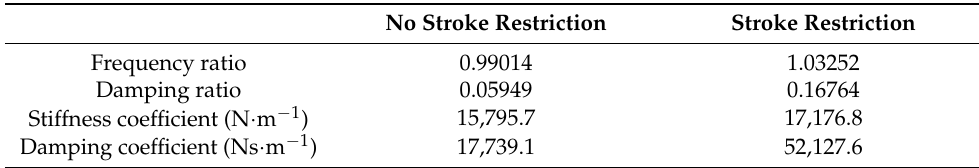
Table 16. Optimization results of TMD parameters.